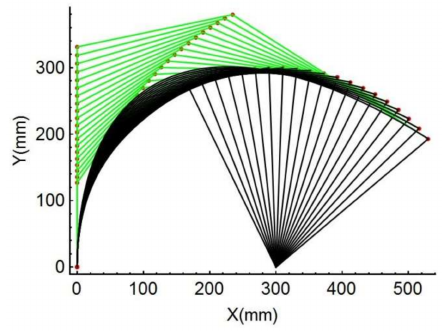
Figure 13. Simulation of the compliant effects during rigid beam rotation.